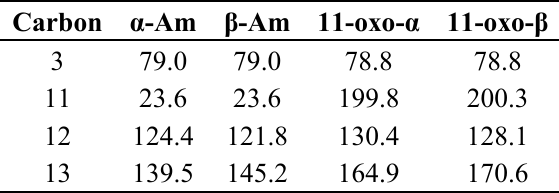
Table 2. 13 C-NMR data for α -amyrin ( α -Am), β -amyrin ( β -Am), 11-oxo- α -amyrin (11-oxo- α ) and 11-oxo- β -amyrin (11-oxo- β ) identified from Dorstenia arifolia [100 MHz, δ (ppm), CDCl 3